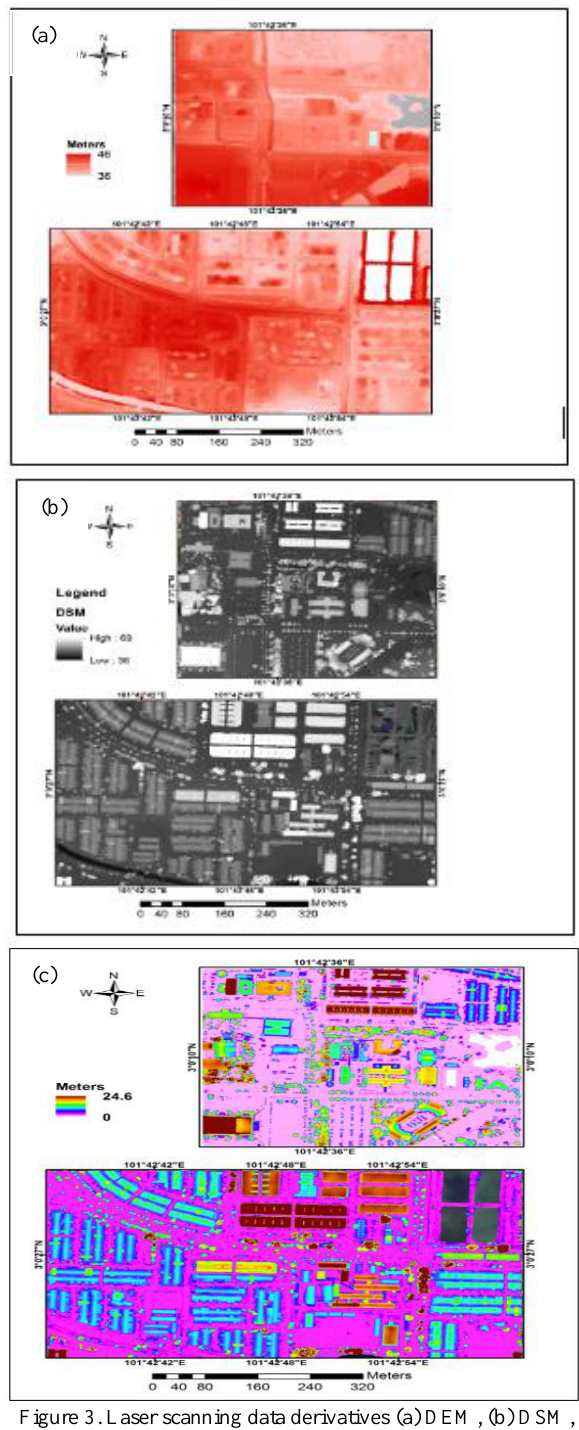
Figure 3. Laser scanning data derivatives (a) DEM, (b) DSM, (c)